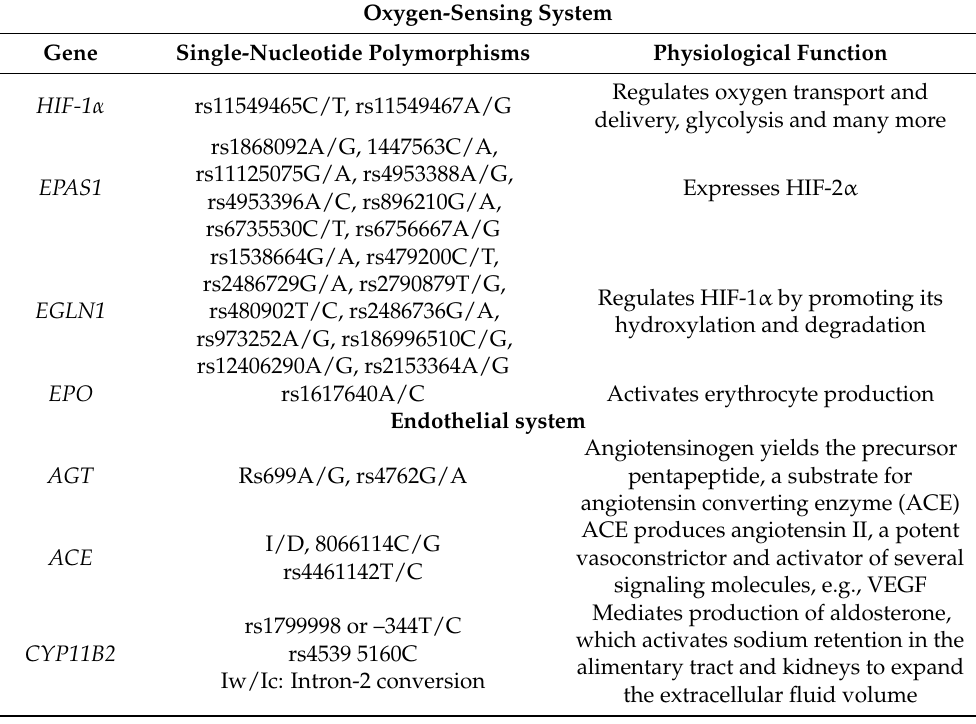
Table 1. Gene polymorphisms impacting physiological and pathological responses to hypobaric